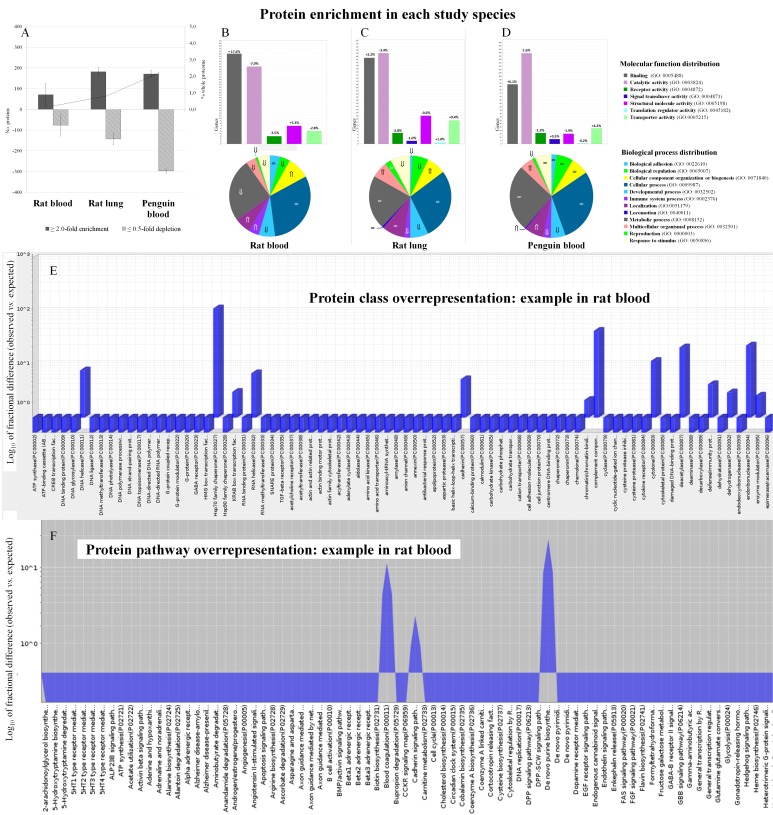
Global protein changes and Gene Ontology (GO, http://www.geneontology.org/) enrichment analysis within Aspergillus-diseased organisms versus control conditions, according to the PANTHER classification system [30,57].A—The bar chart indicates the absolute number of proteins
that were found positively or negatively ≥ 2.0-fold differentially-expressed amongst each species (S1 Table). The dots of the curve indicate the proportion of proteins, expressed in percentages in comparison to the whole known proteome of each studied organism, that were positively or negatively ≥ 2.0-fold differentially-expressed during aspergillosis; B–The multiple pie chart in the upper panel displays distribution of the molecular functions of all the proteins that were identified as positively or negatively ≥ 2.0-fold differentially-expressed in rat blood during experimental aspergillosis vs. control rats challenged with bacterial lipopolysaccharide (LPS); the pie chart of the lower panel shows the corresponding biological processes for the same proteins; C—Results for proteins that were positively or negatively ≥ 2.0-fold changed in rat lung during experimental aspergillosis vs. control rats challenged with LPS; D—Results for proteins that were positively or negatively ≥ 2.0-fold differentially represented in penguin blood during aspergillosis vs. control penguins undergoing non-Aspergillus inflammatory diseases; E–The overlaid area chart of difference obtained by bioinformatic analyses revealed that blood protein enrichment during experimental aspergillosis in rats concerned 28 distinct protein classes, including defense proteins like immunoglobulin superfamily and complement components, nucleases, various mRNA processing factors, helicases, cytokines, serine protease inhibitors and protein phosphatases/kinases; F–The bar chart of difference obtained by bioinformatic analyses revealed that blood protein enrichment during experimental aspergillosis in rats primarily concerned six different pathways: blood coagulation, cadherin signaling pathway, de novo purine biosynthesis, pyruvate metabolism, tricarboxylic acid cycle, and Wnt signaling pathway. Abbreviation: GO, Gene ontogeny; ⇑, positive enrichment >10% gene hit against total biological process hits; ⇓, negative enrichment >10% gene hit against total biological process hits; = , positive or negative enrichment <10% gene hit against total biological process hits.